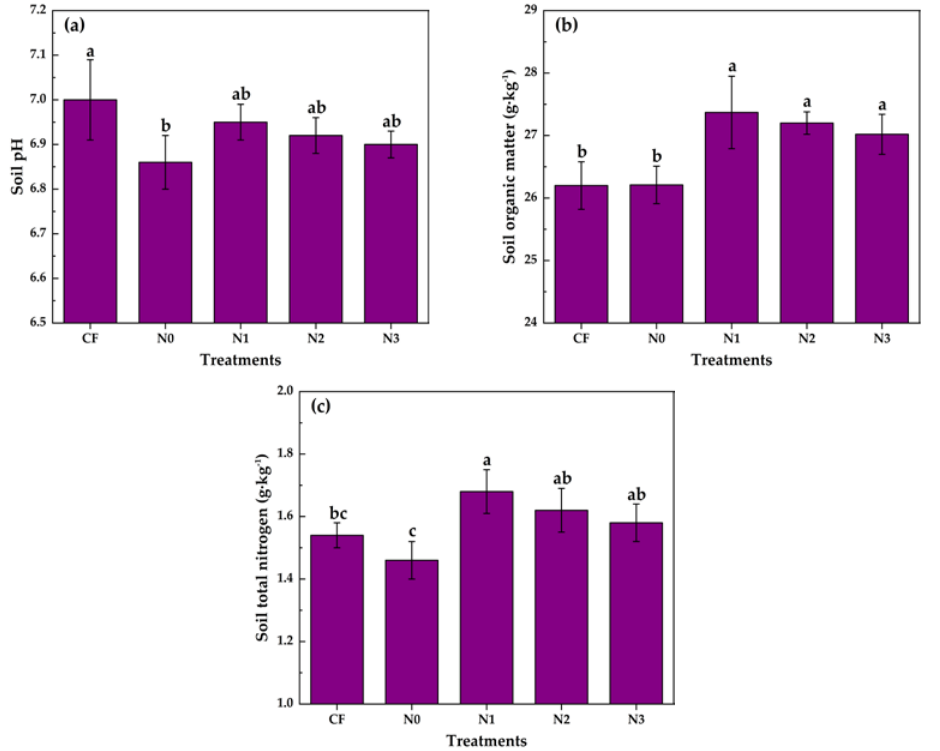
Figure 7. Changes of ( a ) soil pH, ( b ) soil organic matter and ( c ) soil total nitrogen in spring wheat fields under the different nitrogen fertilizer managements. Note: Different lowercase letters in the same indicators indicate significant differences among different treatments ( LSD test, p < 0.05 ).